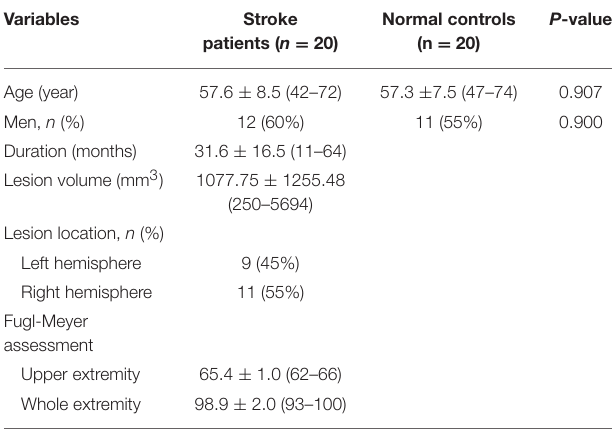
TABLE 1 | Demographic and clinical information of patients with stroke and